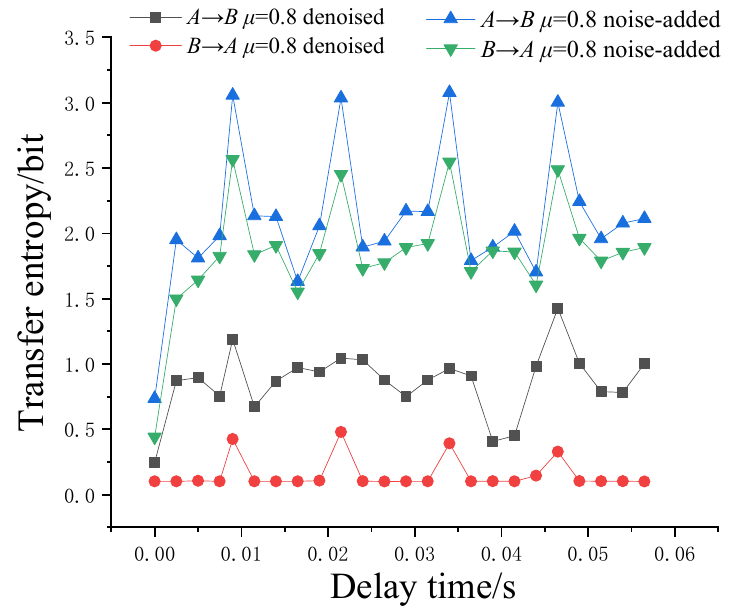
A B and before and after noise reduction.